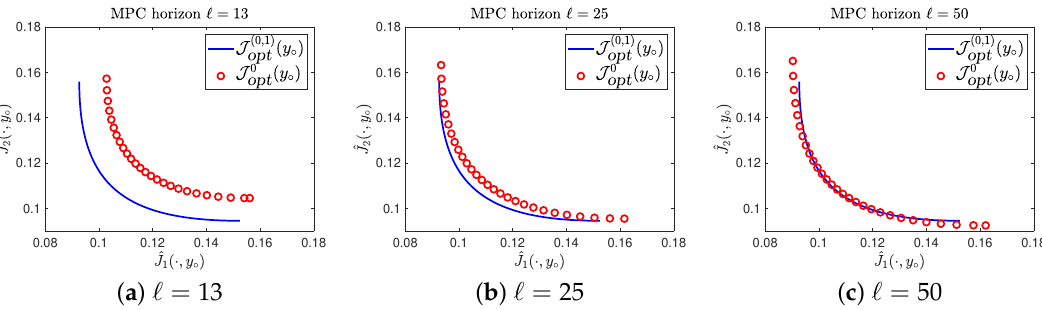
( 0,1 ) ( y ◦ ) and J 0 ( y ◦ ) for different MPC horizon opt opt